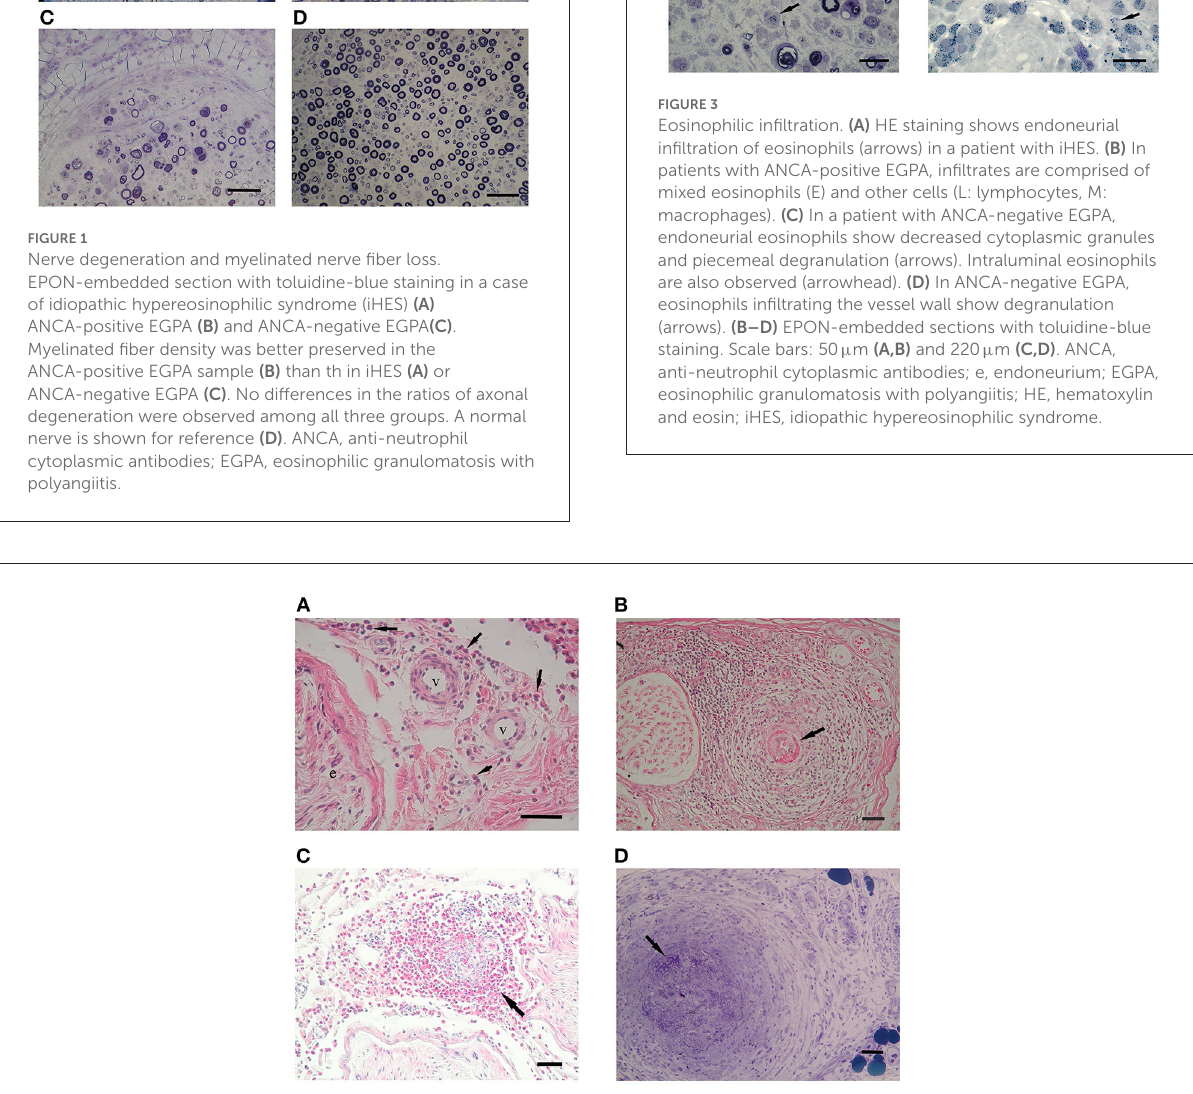
FIGURE2 Vasculitic features. Hematoxylin and eosin (HE) staining in patients with iHES (A) ANCA-positive EGPA (B) and ANCA-negative EGPA (C) . In iHES, epineurial vessel walls show no disruption, although infiltrates of eosinophils (arrows) can be observed in the perivascular interspace. In ANCA-positive EGPA, fibrinoid necrosis of the endothelial layer (arrow) and infiltrates in the vessel wall are visible. In ANCA-negative EGPA, epineurial vasculitis with massive eosinophilic infiltrates are visible, although no fibrinoid necrosis can be seen. (D) A patient with reactive HES showed fibrinoid necrosis and small arteritis. Scale bar: 50 µ m for (A–D) . ANCA, anti-neutrophil cytoplasmic antibodies; EGPA, eosinophilic granulomatosis with polyangiitis; iHES, idiopathic hypereosinophilic